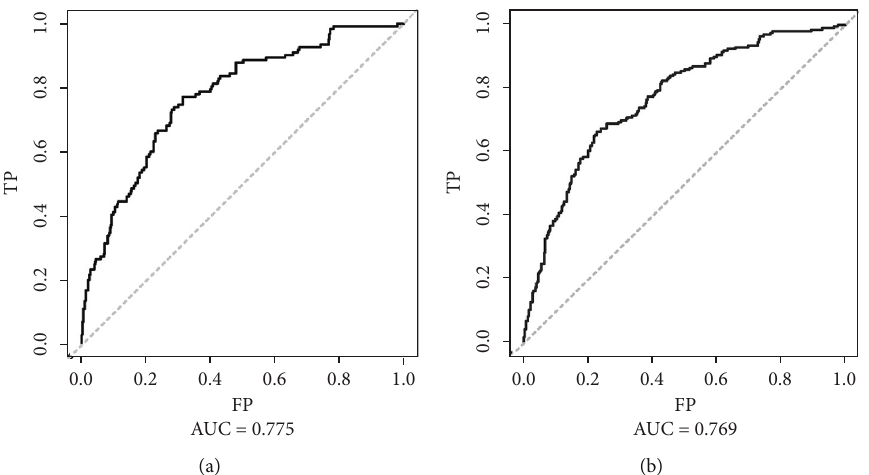
Figure 3: The ROC curves of external validation: (a) The mortality that occurred within one year after admission to ICU; (b) the mortality that occurred within three years after admission to